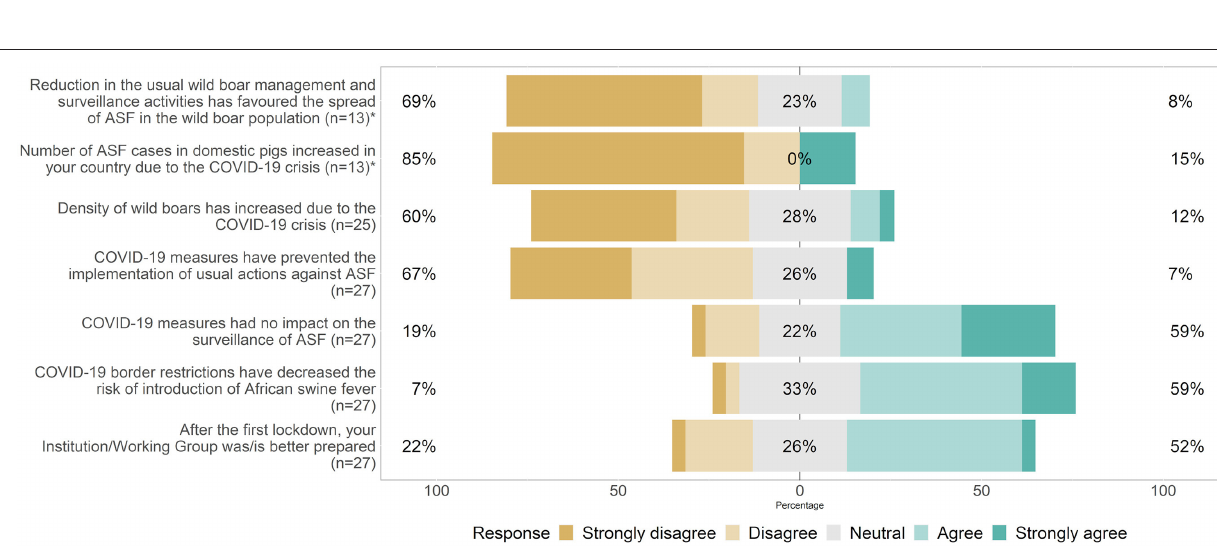
Frontiers in Veterinary Science |